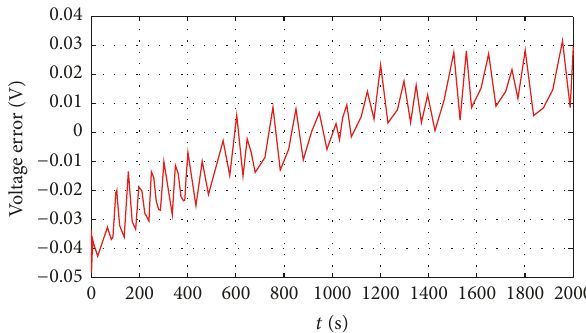
Figure 6: The difference of estimated voltage and tested voltage.